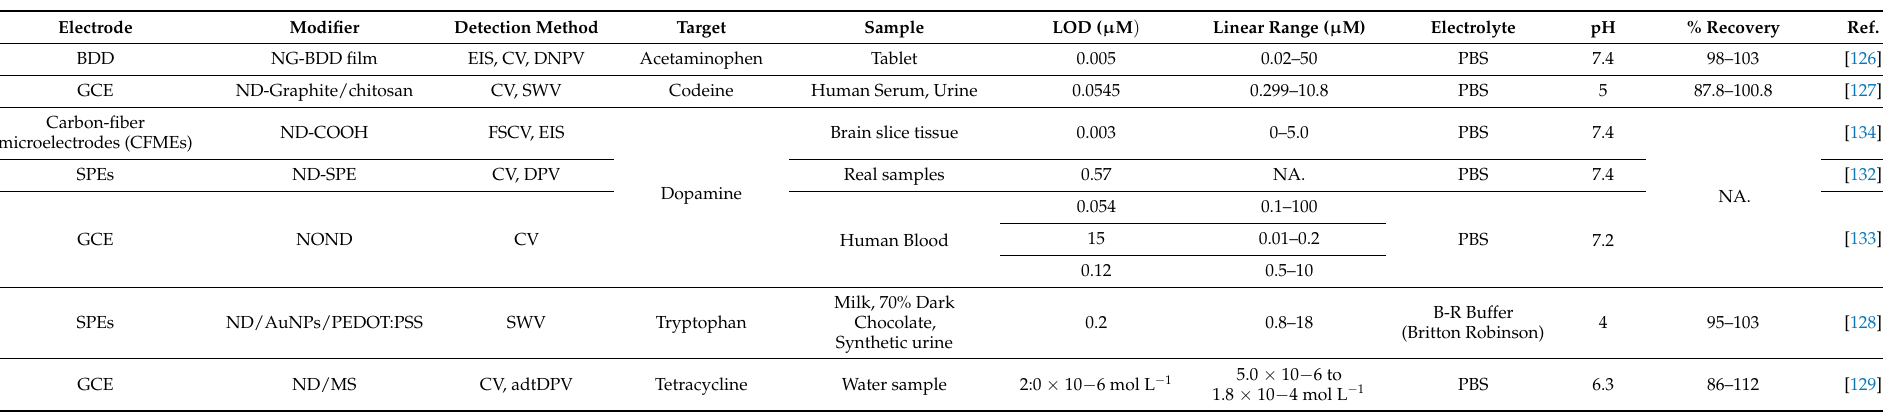
Table 4. Summary of nanodiamonds for pharmaceutical sensor